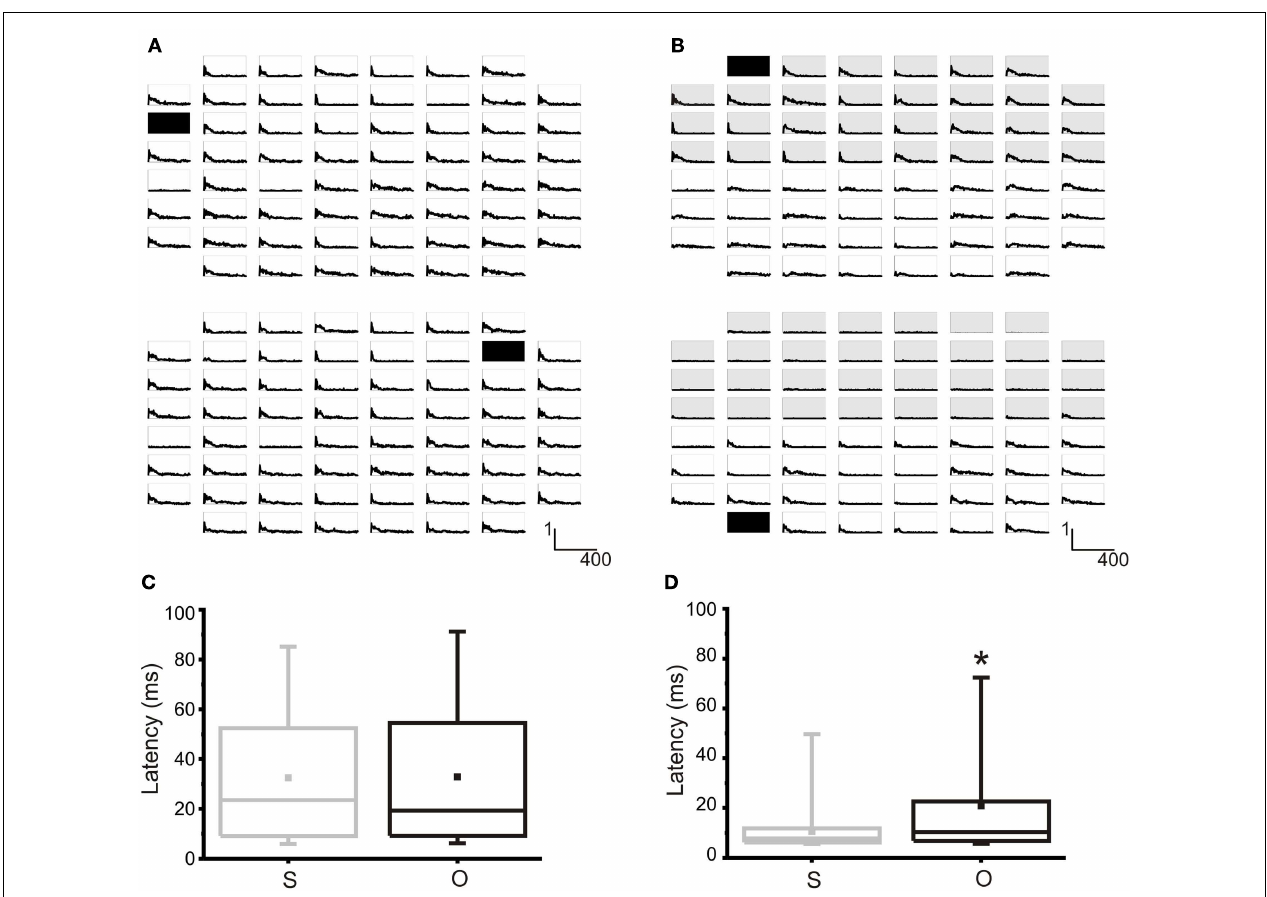
evoking a spike. (C) Box-plot of the latency from the first evoked spikes in the same (S) or other (O) compartment with respect to stimulating electrodes. No statistical differences can be noted in a random culture. N = 11 random cultures. (D) Box-plot of the latency from the first evoked spikes in the same (S) or other (O) compartment with respect to stimulating electrodes. In a modular network, the latency between the stimulus and the first evoked spike is statistically lower for the electrodes belonging to the same cluster of the stimulating electrodes. N = 6 modular cultures. Box range: percentile 25–75; Box whiskers: percentile 5–95; line: median; square: mean. Mann–Whitney test for not-normal data, significance level = * p <